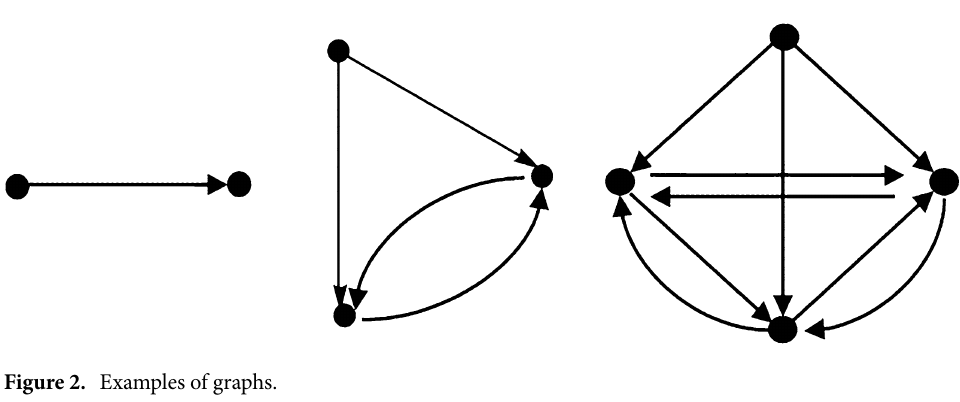
Figure 2. Examples of